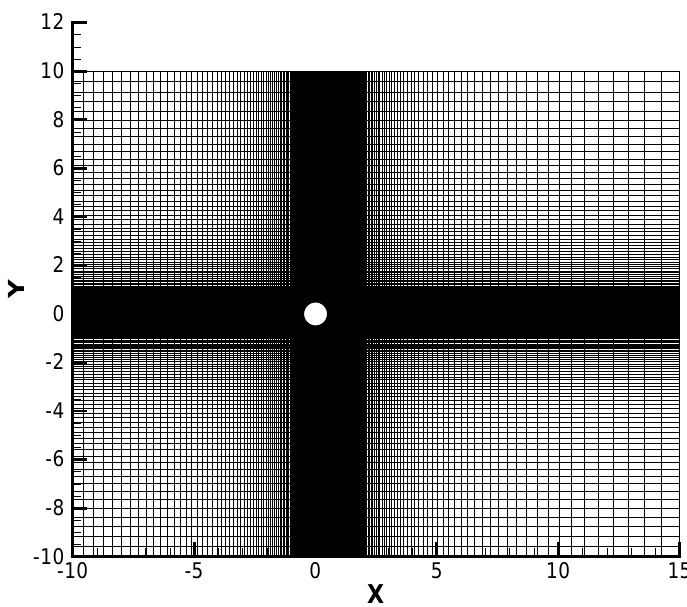
Figure 6. Mesh for the case of the flow past a cylinder at Re = 100.